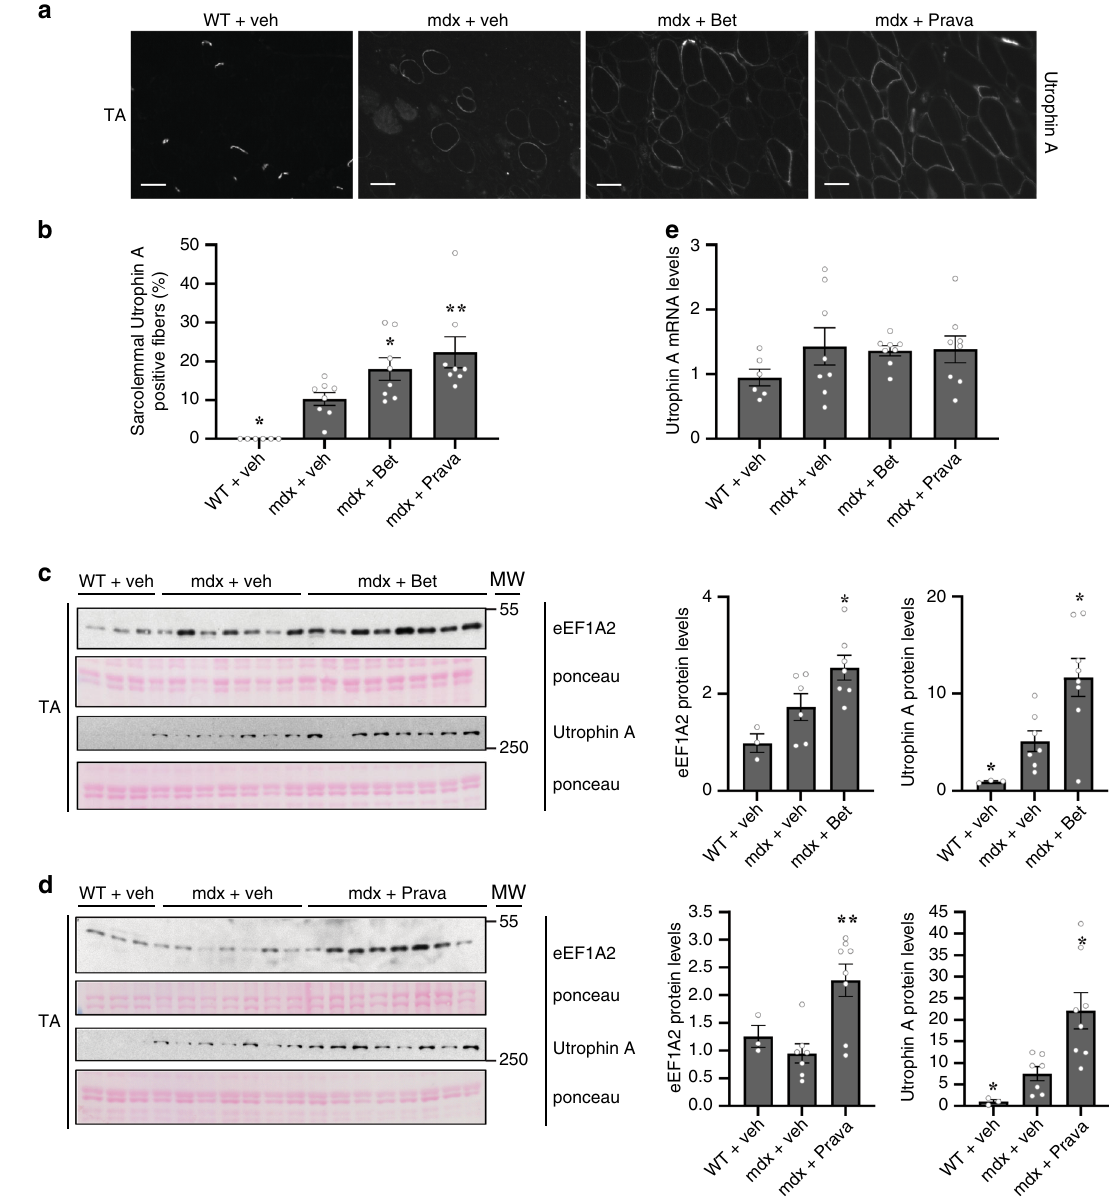
Fig. 5 Increase of sarcolemmal localization and protein levels of utrophin A by Betaxolol and Pravastatin treatment in mdx mice. a Representative examples of cross-sections obtained from TA muscles of wild-type (WT) mice and mdx mice treated with Betaxolol (Bet), Pravastatin (Prava) or vehicle control (saline) for 4 weeks, were immunostained with utrophin A (UTR-A) antibody. Scale bars, 50 mm. b Quanti fi cation of sarcolemmal utrophin A positive fi bers to total muscle fi bers. c , d Western blots and quanti fi cation of eEF1A2 and utrophin A protein levels normalized to ponceau using protein extracts from TA muscles from the treated mdx mice. e Utrophin A mRNA levels in Bet-, Prava- or vehicle-treated mdx mouse TA muscles, standardized to 18S. N = 6 for WT and N = 8 for mdx + veh or treated. Error bars represent SEM. * P < 0.05, ** P < 0.01, vs vehicle control. One-way ANOVA and Bonferroni post-hoc test was performed to determine statistical differences. Source Data for b – e are provided in the Source Data